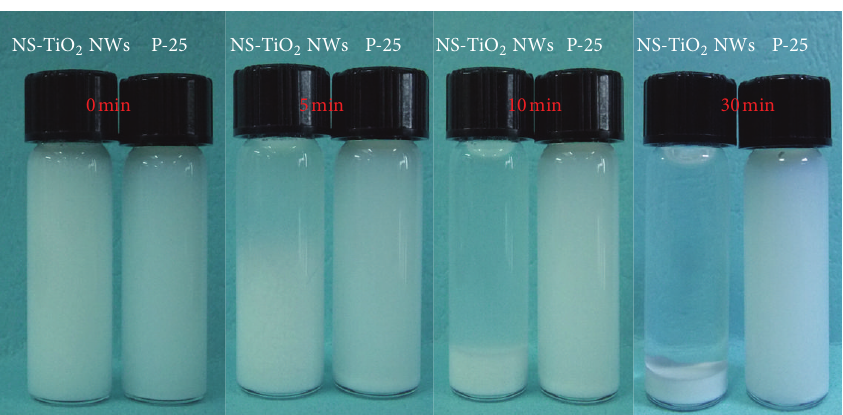
Figure 4: Sedimentation for 30 min in aqueous suspension of NS-TiO 2 NWs and P-25.